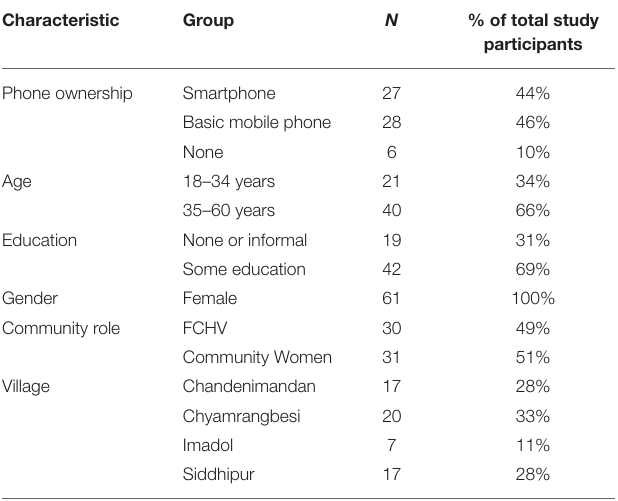
TABLE 1 | Demographics of participants in target